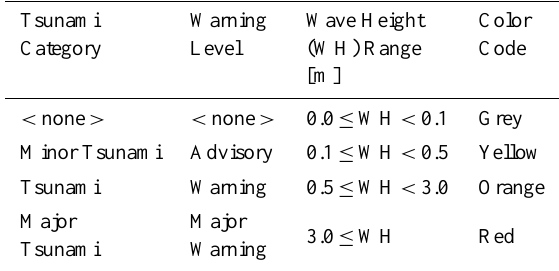
Table 1. Mapping of wave heights to Warning Levels.